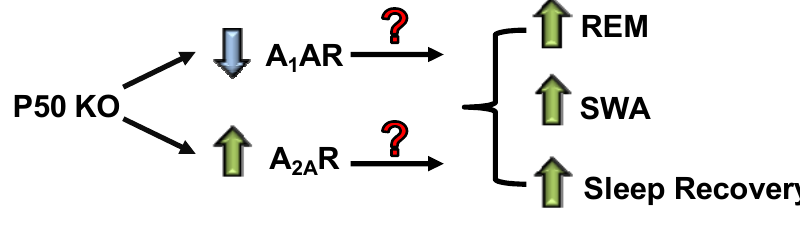
Figure 1. Proposed model of regulation of sleep by adenosine receptors in p50 KO